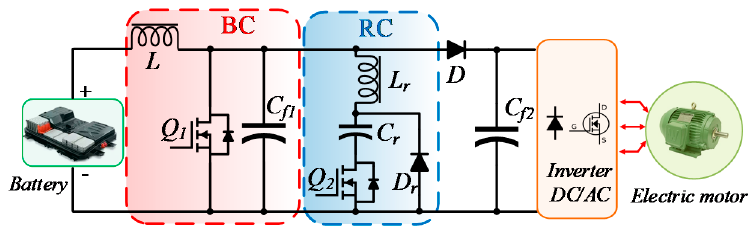
Figure 8. Boost converter with the resonant circuit. Figure 8 . Boost converter with the resonant circuit.